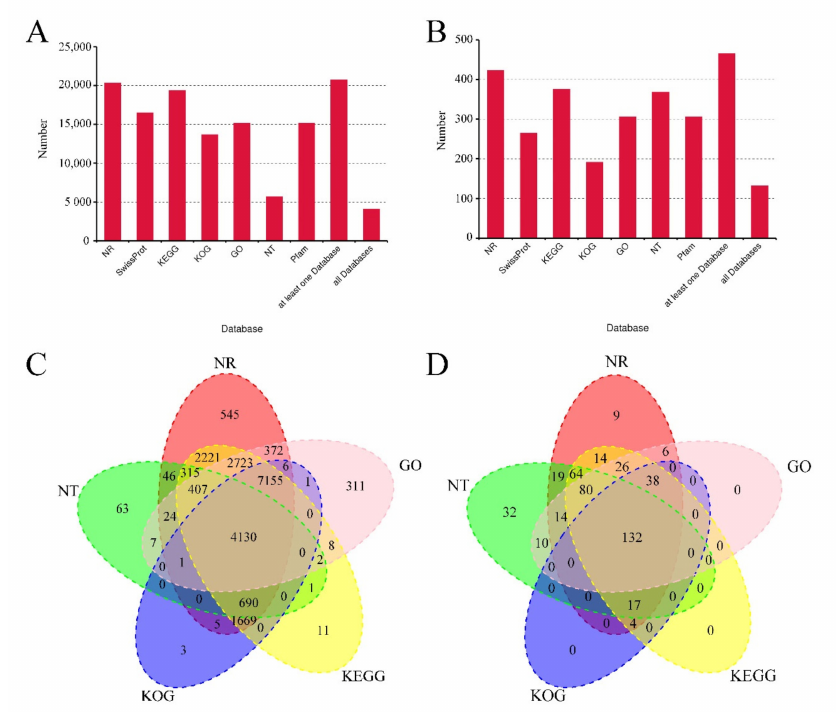
Figure 2. All Databases annotation statistical results. ( A , B ) are annotations’ statistical results for coral and zooxanthellae, respectively. The horizontal axis represents the database and the vertical axis the number of genes annotated to the database. ( C , D ) are annotation Venn diagrams of coral and zooxanthellae, respectively. The sum of the numbers in each large circle represents the number of transcripts annotated by the database, and the overlapping part of the circles represents the transcript annotations shared between